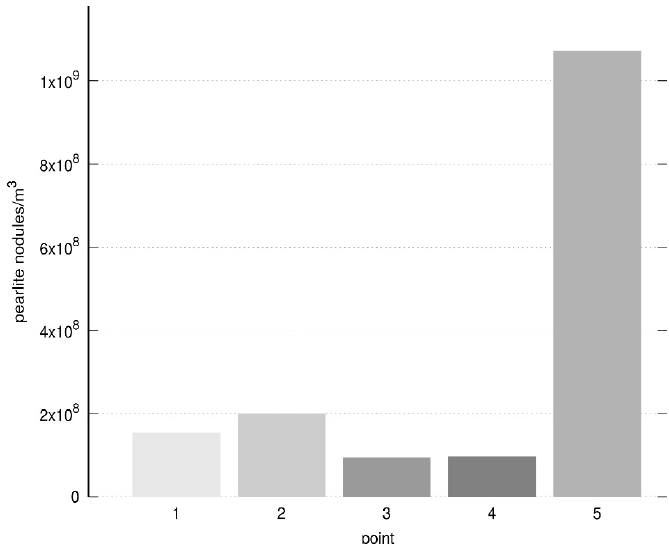
Figure 8. Simulated number of pearlite nodules per unit volume at each of the five regions.